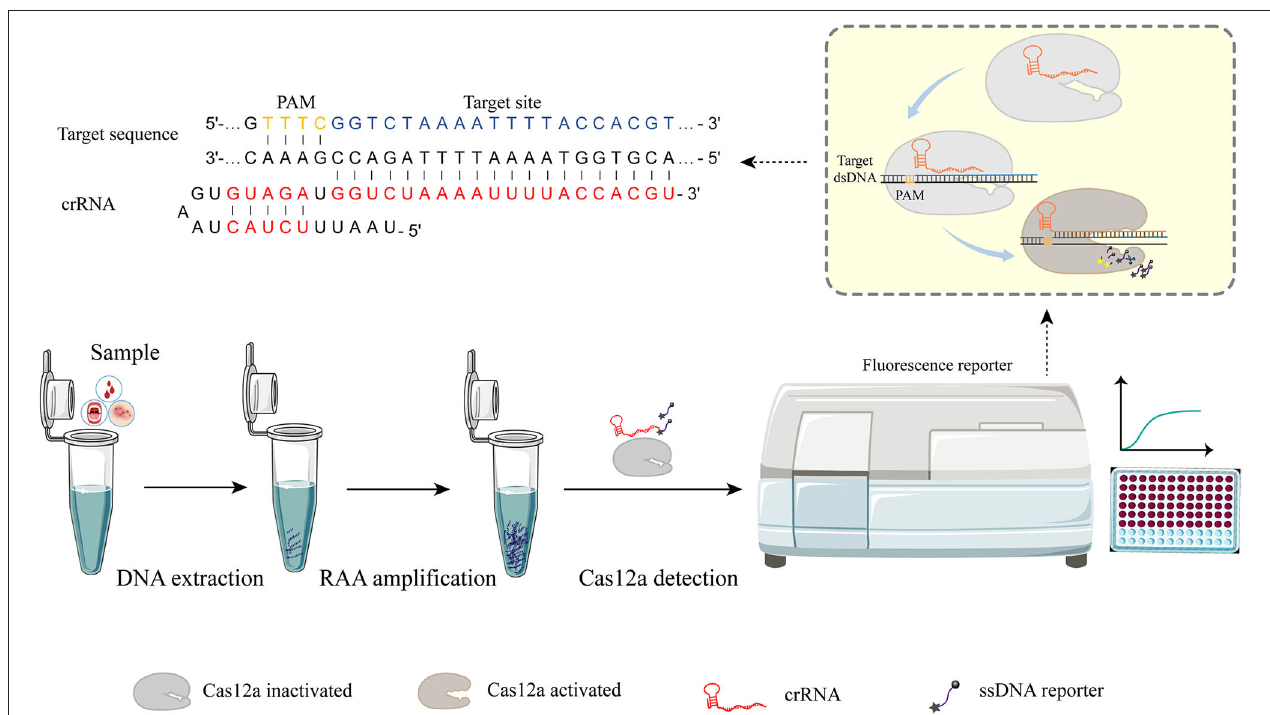
FIGURE 1 | RAA-Cas12a detection system. The detection process can be roughly divided into three parts. Step I, the sample was pretreated and DNA was extracted as the substrate for the next step. Step II, nucleic acid was amplified by recombinase-aided amplification (RAA). Step III, Cas-based signal generation. Cas12a-crRNA complex is activated when crRNA is employed to recognize the target sequence by a short protospacer-adjacent motif (PAM) sequence. After the Cas12a-crRNA complex binding with the target sequence, the cis cleavage for both strands of the dsDNA target occurs. The activated Cas12a-crRNA complex possesses non-specific cleavage (trans cleavage) activity that can cleave non-specific ssDNA reporters to generate fluorescence signals that are captured by the